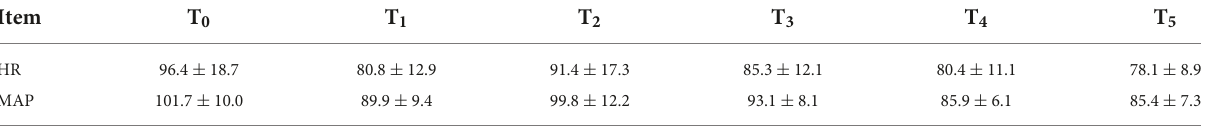
TABLE 3 Hemodynamic changes (HR, beats/min; MAP, mmHg; n = 30).